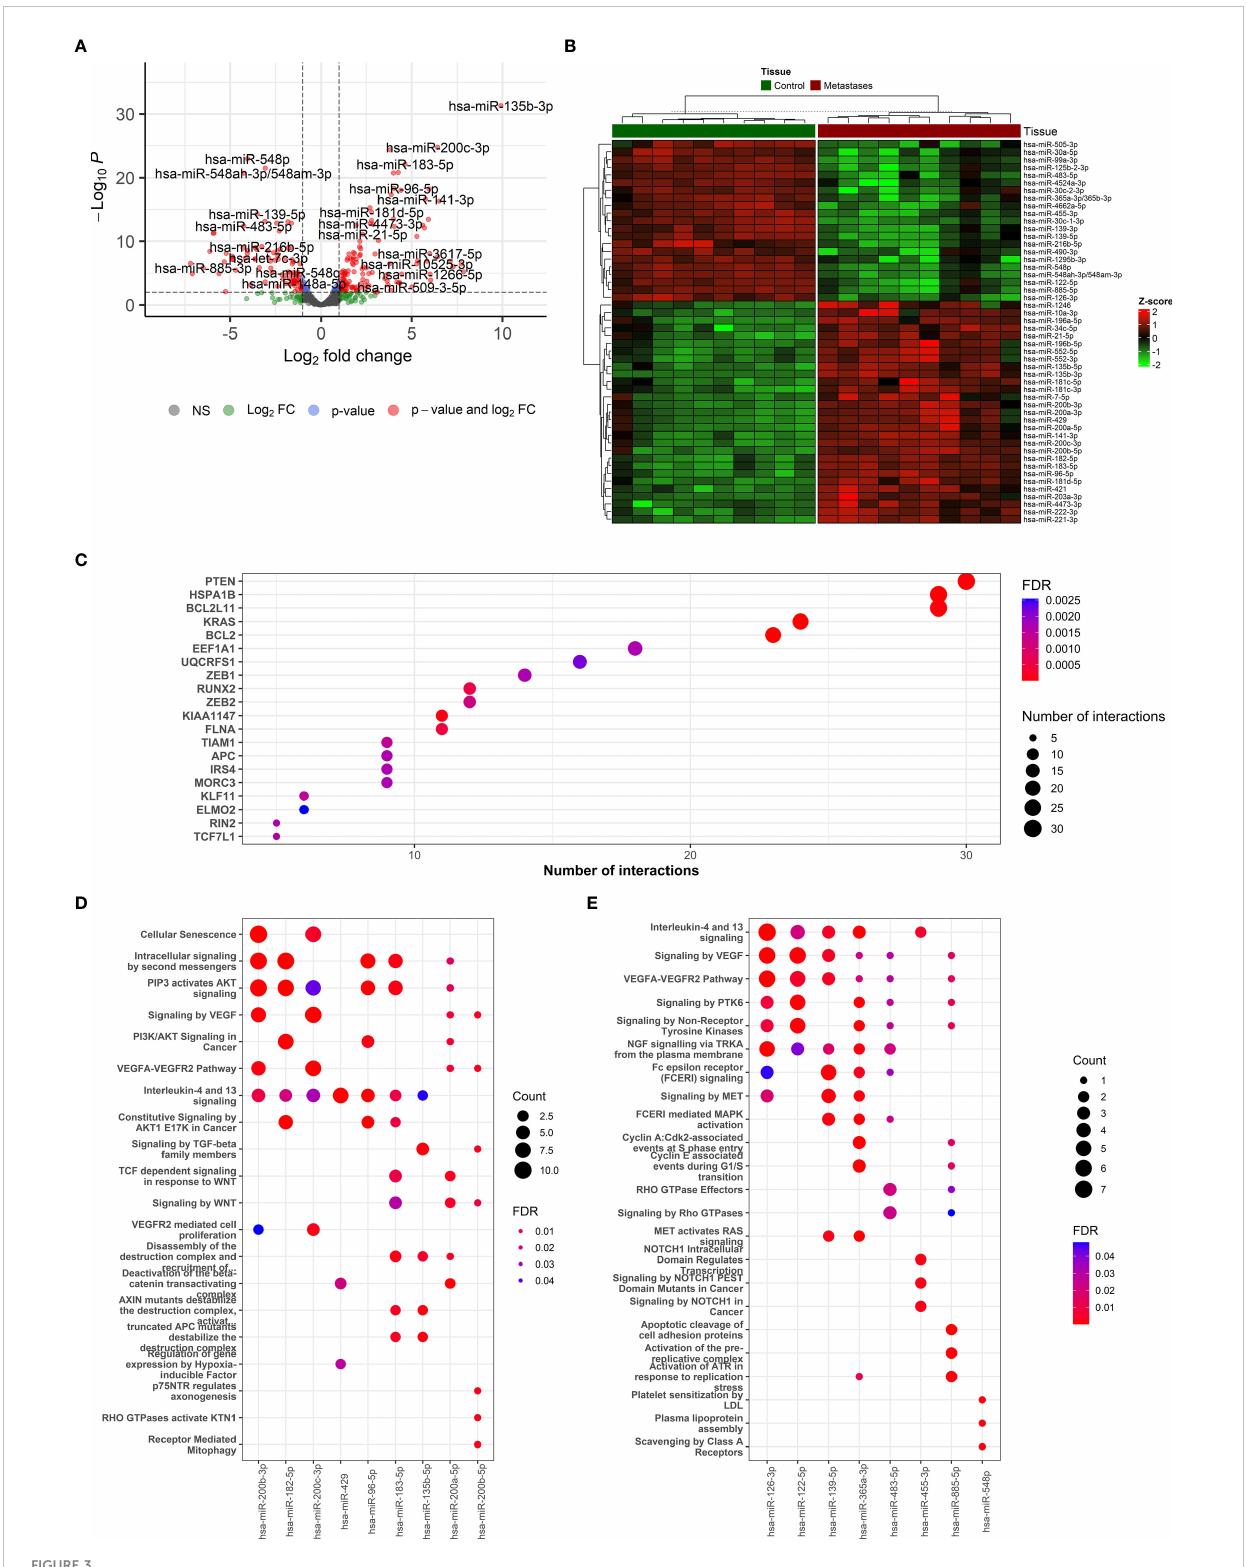
FIGURE 3 The description if miRNA-based results and functional enrichment of its targets. (A) Volcano plot reporting the log2FC and the adjusted p-value in the DE analysis between metastasis and adjacent liver tissue. Thresholds: adjusted p-value < 0.0+ and |log2FC| > 1. (B) Heatmap of top 50 differentially expressed miRNAs between metastasis and adjacent liver tissue. (C) The top miRNA targets from target enrichment analysis. (D) The Reactome enrichment analysis of the top 10 differentially up-regulated miRNAs. (E) The Reactome enrichment analysis of the top 10 differentially down-regulated